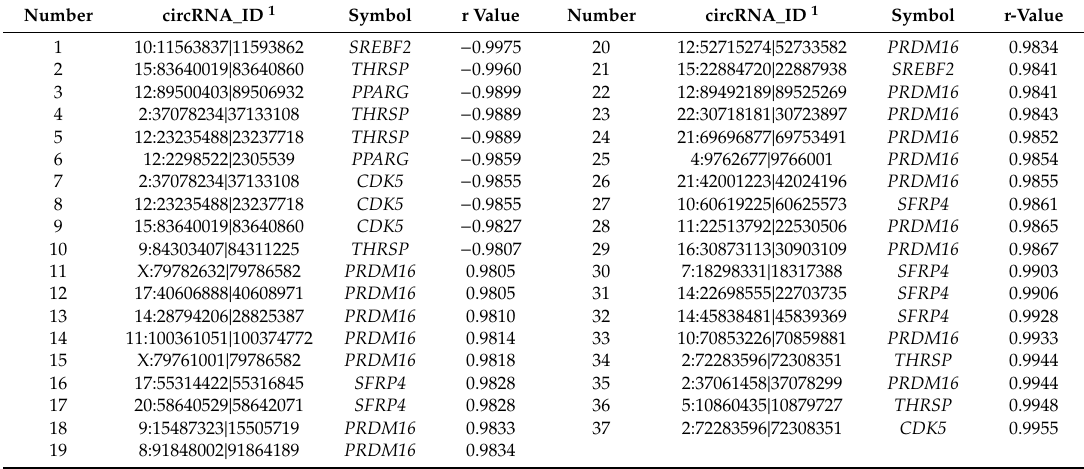
Table 2. The circRNA–mRNA pairs with potential e ff ects on fat deposition.